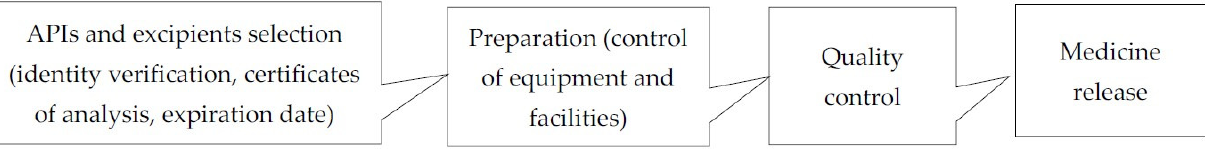
Figure 1. Research design.